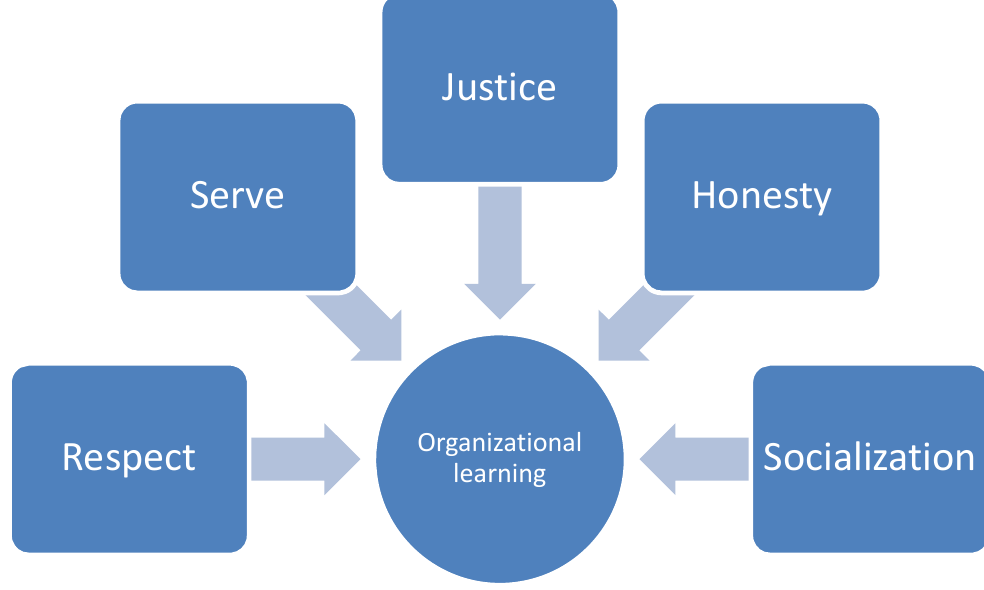
Fig. 1. The proposed framework of the